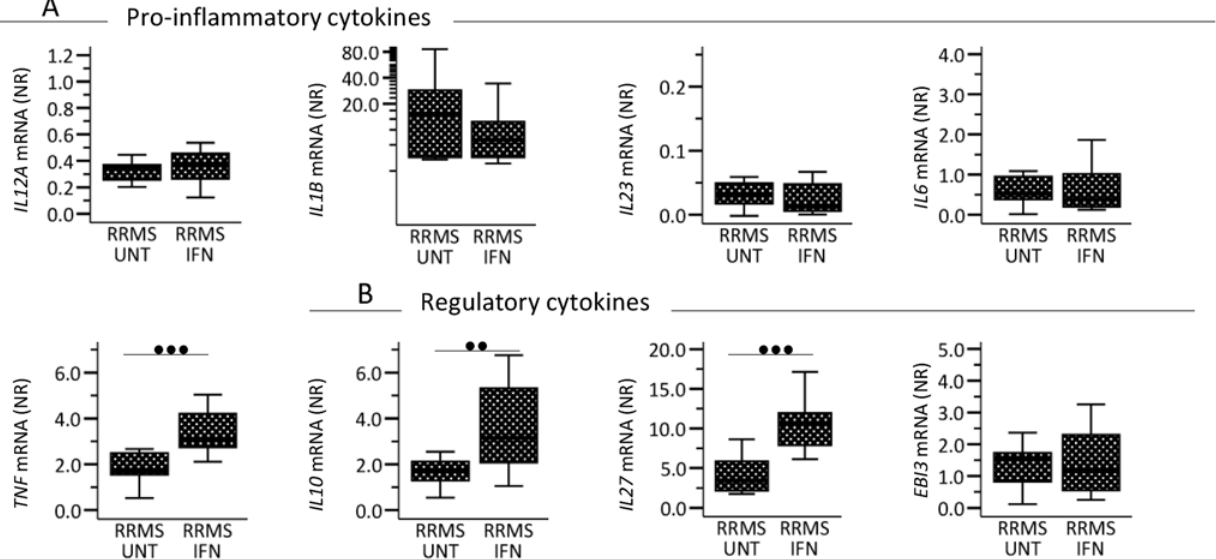
Fig 3. Circulating monocytes ’ mRNA expression of genes encoding (A) pro- inflammatory and (B) immunoregulatory cytokines in 11 untreated (UNT) and 14 interferon-(IFN) β treated patients with relapsing-remitting multiple sclerosis (RRMS). IFN- β -treated patients were sampled 36 – 48 hours after their last injection of IFN- β . CD14 + cells were isolated by immunomagnetic labeling separation. Gene expression levels are given as normalization ratio (NR), boxes represent interquartile range, median value is indicated as a line, whiskers represent range. Studies were made on the sub-study 2 population. Statistics was by the Mann-Whitney U test. (cid:129) = p < 0.05, (cid:129)(cid:129) = p < 0.005; (cid:129)(cid:129)(cid:129) = p < 0.001.